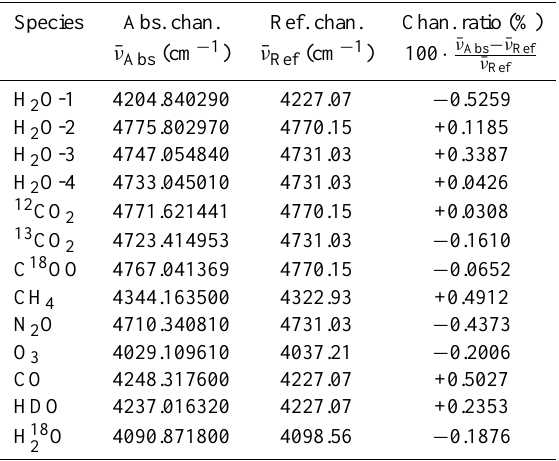
Table 1. Channel pairs investigated in this paper. They are adopted from the ACCURATE satellite mission concept. Species Abs. chan. Ref.